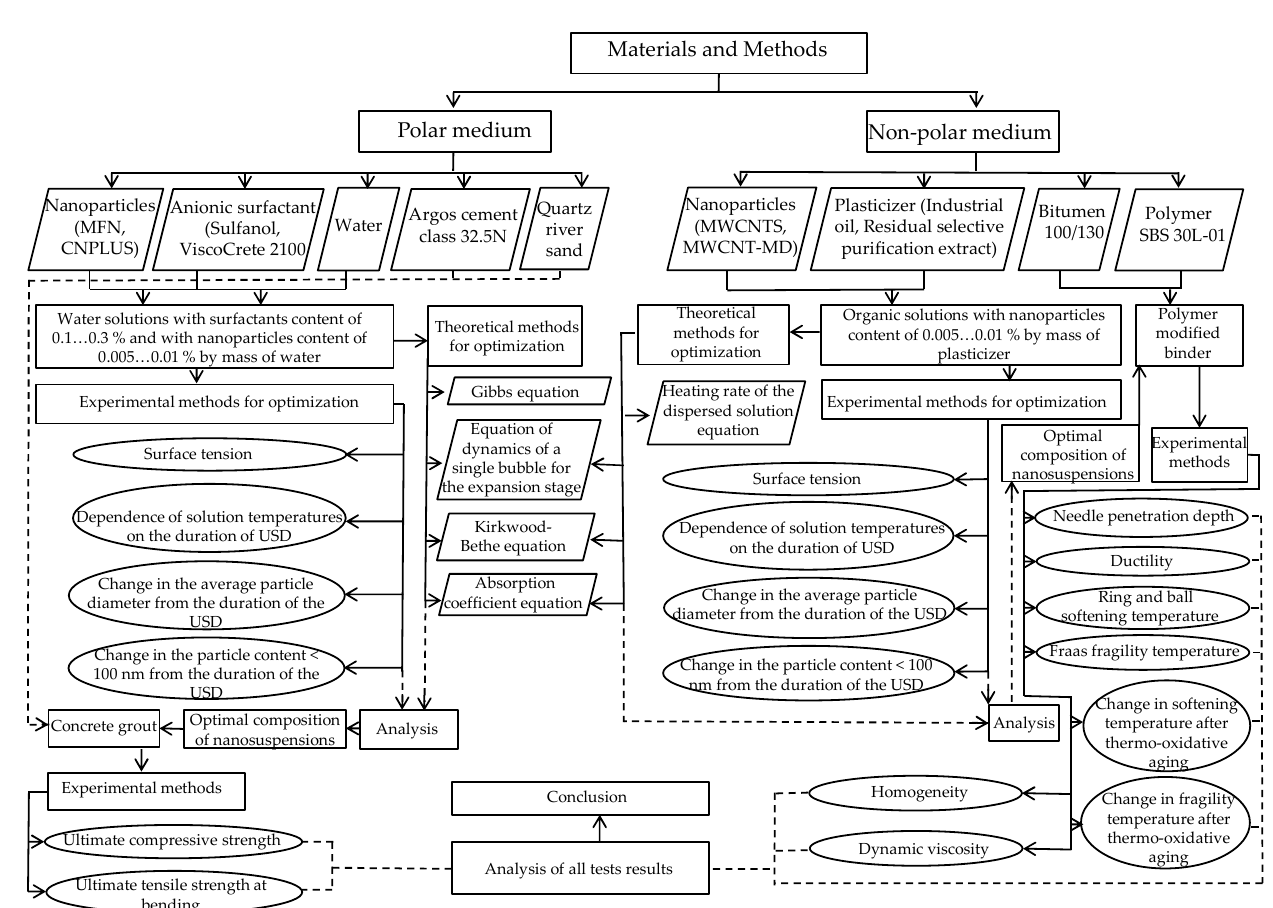
Figure 5. The flow chart of the research approach.